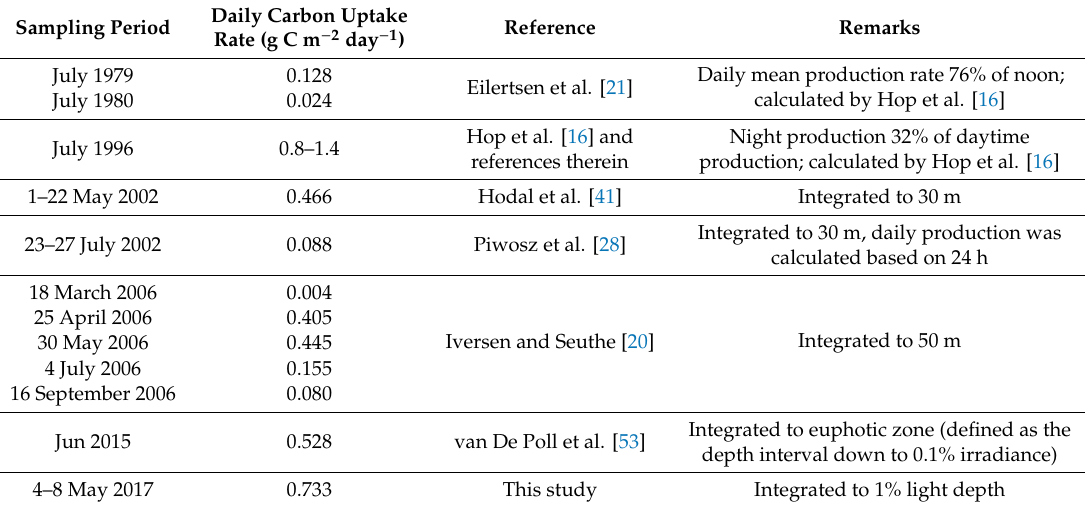
Table 4. Investigations of daily carbon uptake rate in